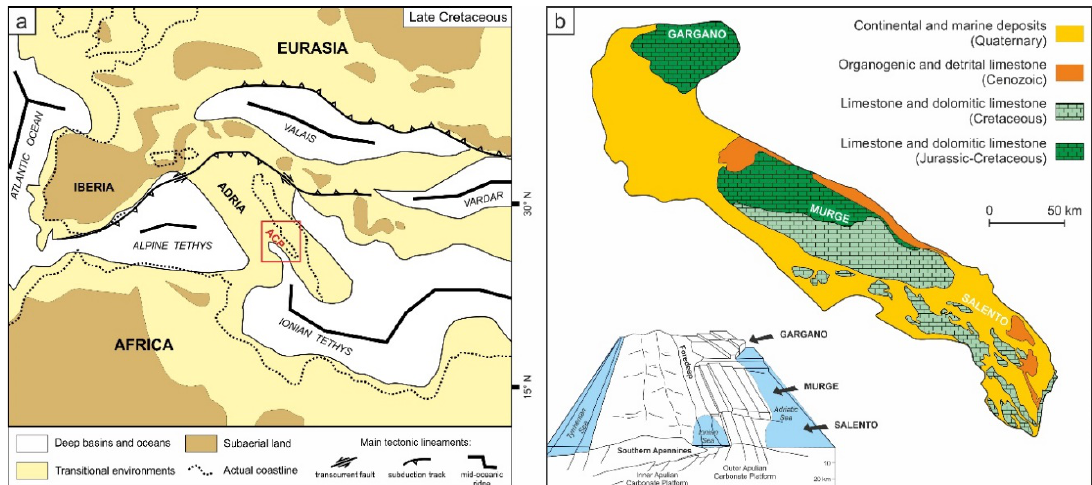
Figure 1. ( a ) Paleogeographic sketch of the Mediterranean area during the Late Cretaceous period (Modified from Ricchetti, et al. [18]). The red box shows the location of the Apulia Carbonate Platform (ACP) microplate. ( b ) Simplified geological map of Apulia and the position of the Gargano, Murge, and Salento tectonic blocks.